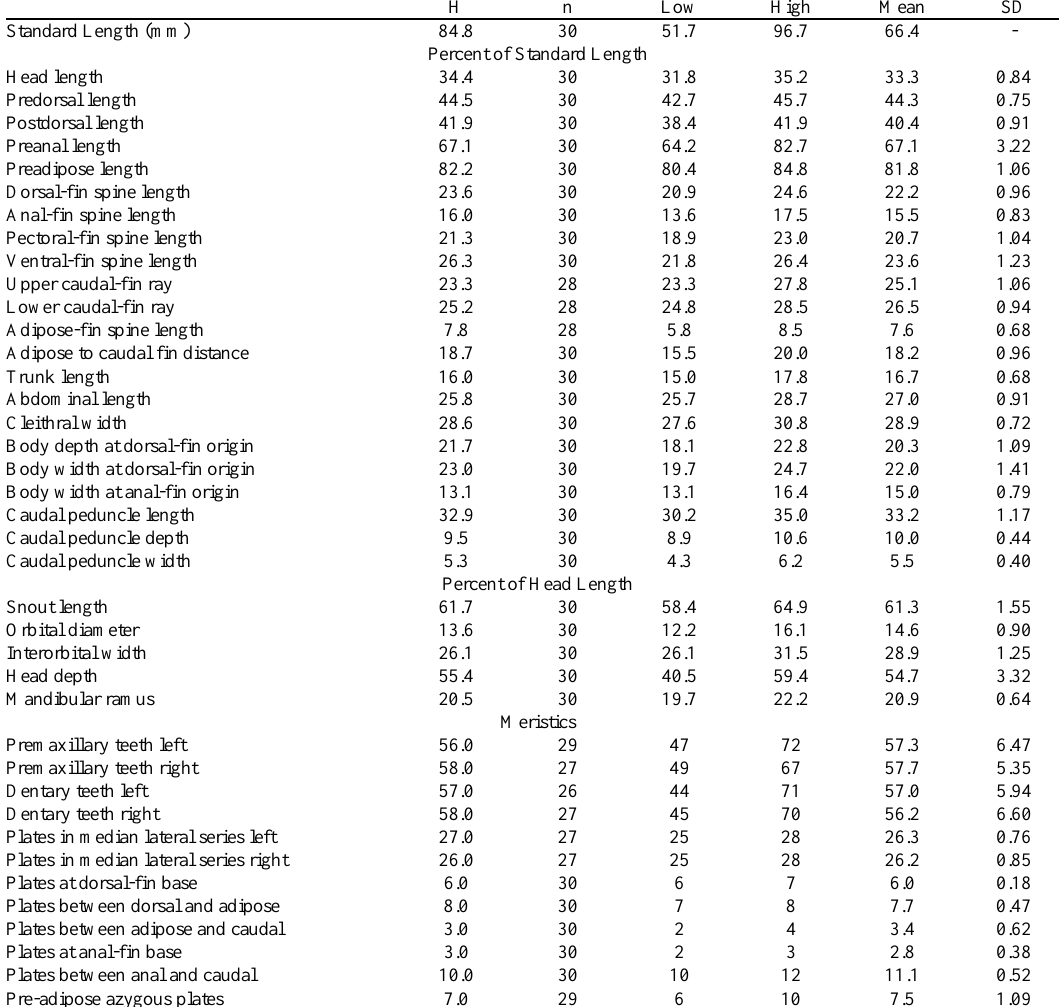
Table 1. Morphometric and meristic data of Pareiorhaphis ruschii . Values are given as percents of standard length or head length. H = holotype, n = number of specimens, and SD = Standard